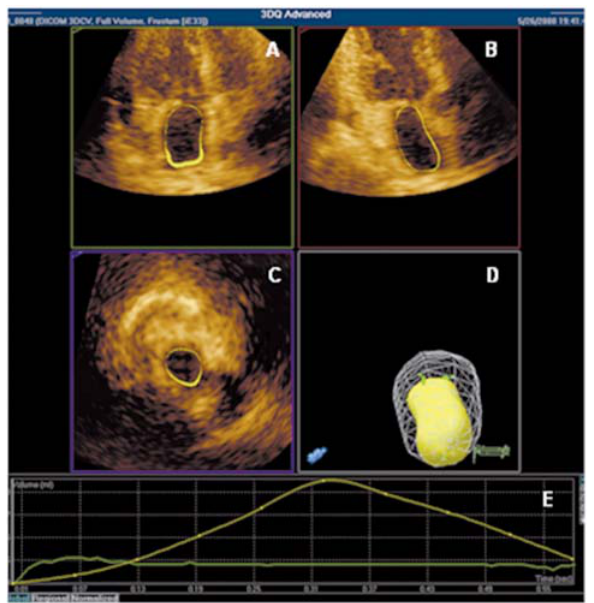
Fig. 2. Delineamento do endocárdio atrial no processo de análise dos volumes sistólico e diastólico (A, B e C). Podemos observar a variação volumétrica atrial esquerda entre os momentos do ciclo cardíaco (D e E)